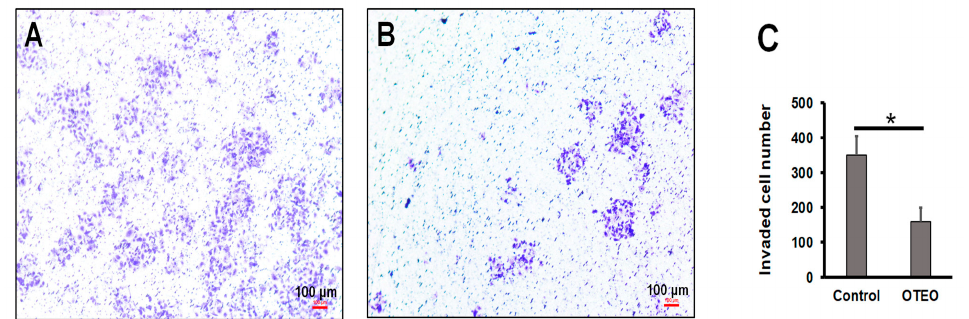
Figure 3. OTEO inhibits invasion by AGS cells, determined using the QCM ECMatrix Cell Invasion Assay kit: ( A ) AGS control cells, ( B ) AGS cells treated with OTEO, and ( C ) enumeration of invasive cells. Data are shown as mean ± SD. Scale bars indicate 100 µm. * p < 0.05 indicated significant difference relative to the control group.